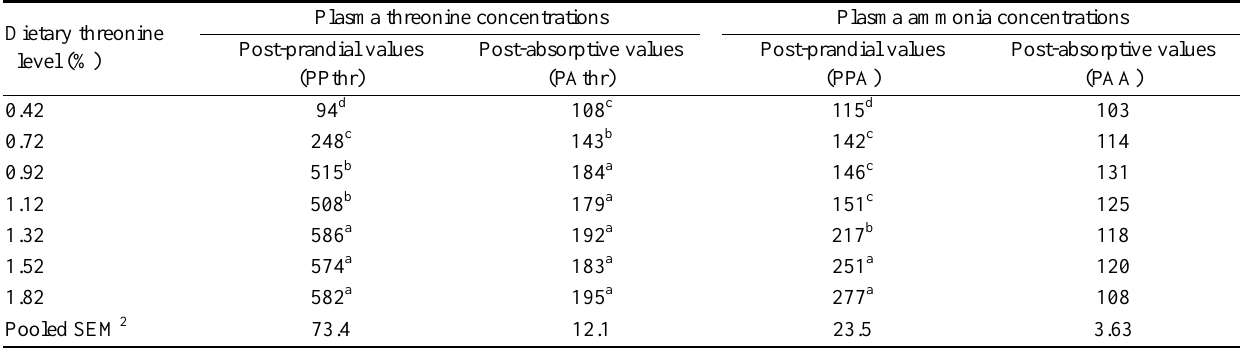
Table 3. Plasma post-prandial (5 h after intubation) and post-absorptive (24 h after intubation) threonine and ammonia concentrations (nmol/mL) of rainbow trout fed graded levels of dietary threonine 1